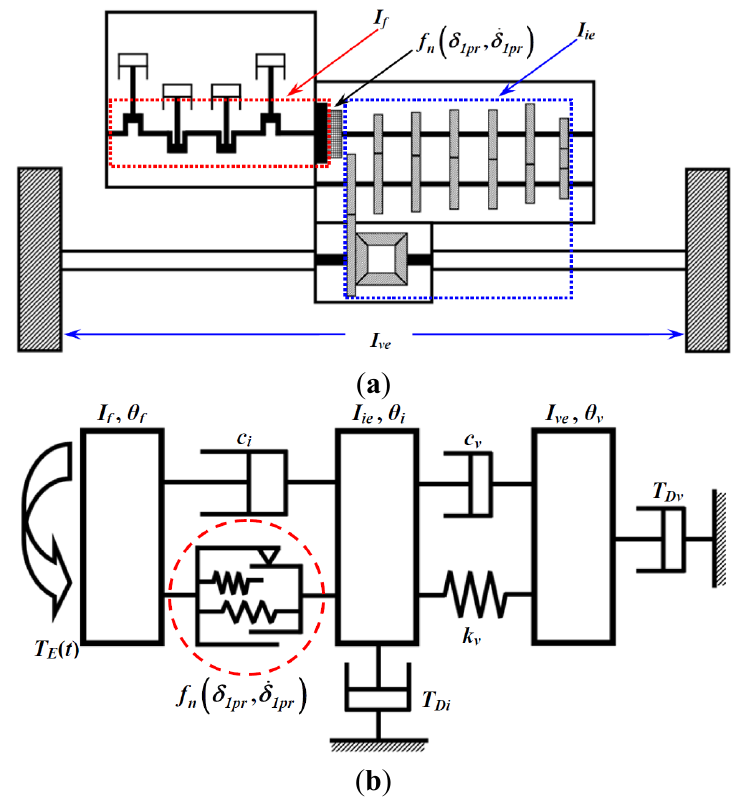
Figure 1. A practical driveline with a front-engine and front-wheel layout and a three degree-of-freedom (3DOF) nonlinear torsional system model with multi-staged clutch dampers: ( a ) physical driveline; and ( b ) schematic diagram with piecewise-type